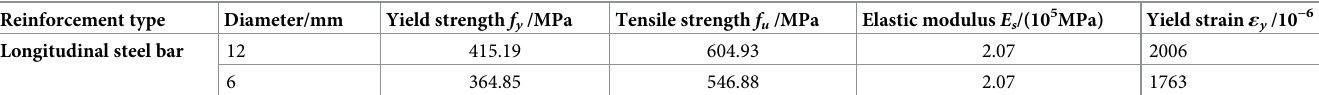
Table 4. Mechanical properties of steel bar.